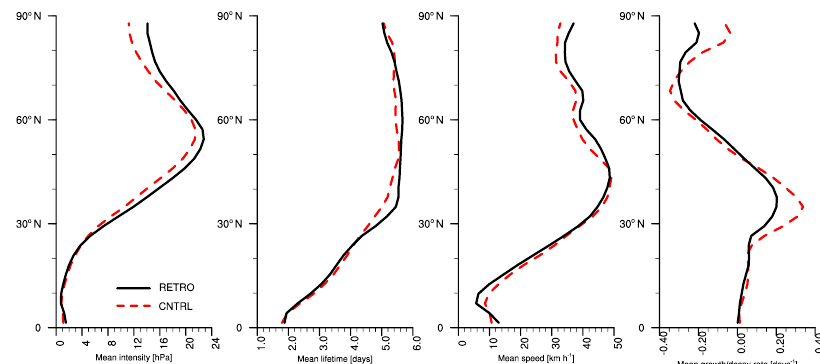
Figure E1. Zonal averaged statistics obtained from the tracking algorithm for the DJF season in the Northern Hemisphere.